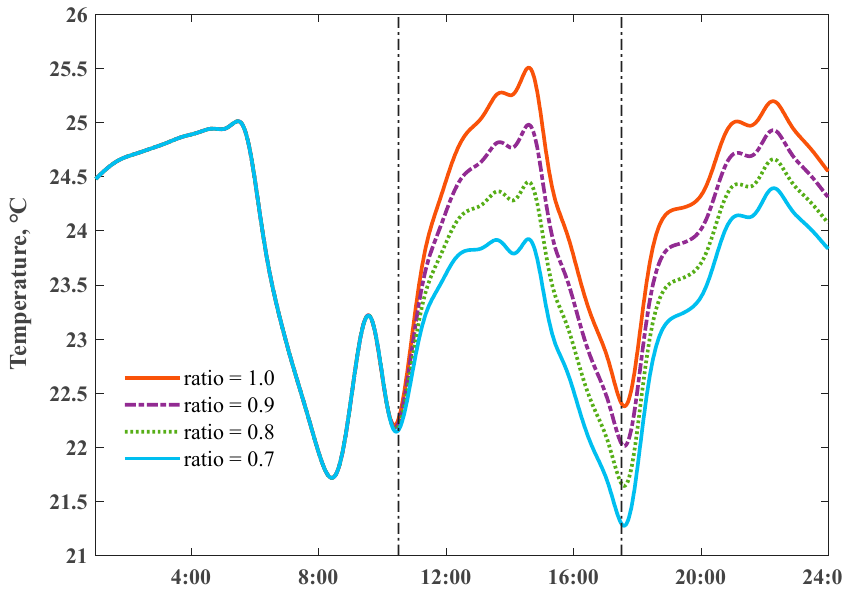
Figure 13. Changes in indoor air temperature profiles under different heating power inputs on 18 January 2020.